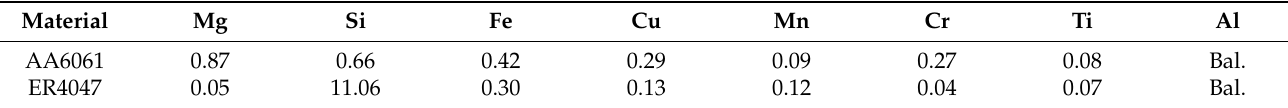
Figure 1. Schematic of ( a ) experimental setup and ( b ) the adjustment of average current. Table 1. Chemical compositions of AA6061 and ER4047 (wt.%). Table 2. Welding process parameters for P-GMAW.